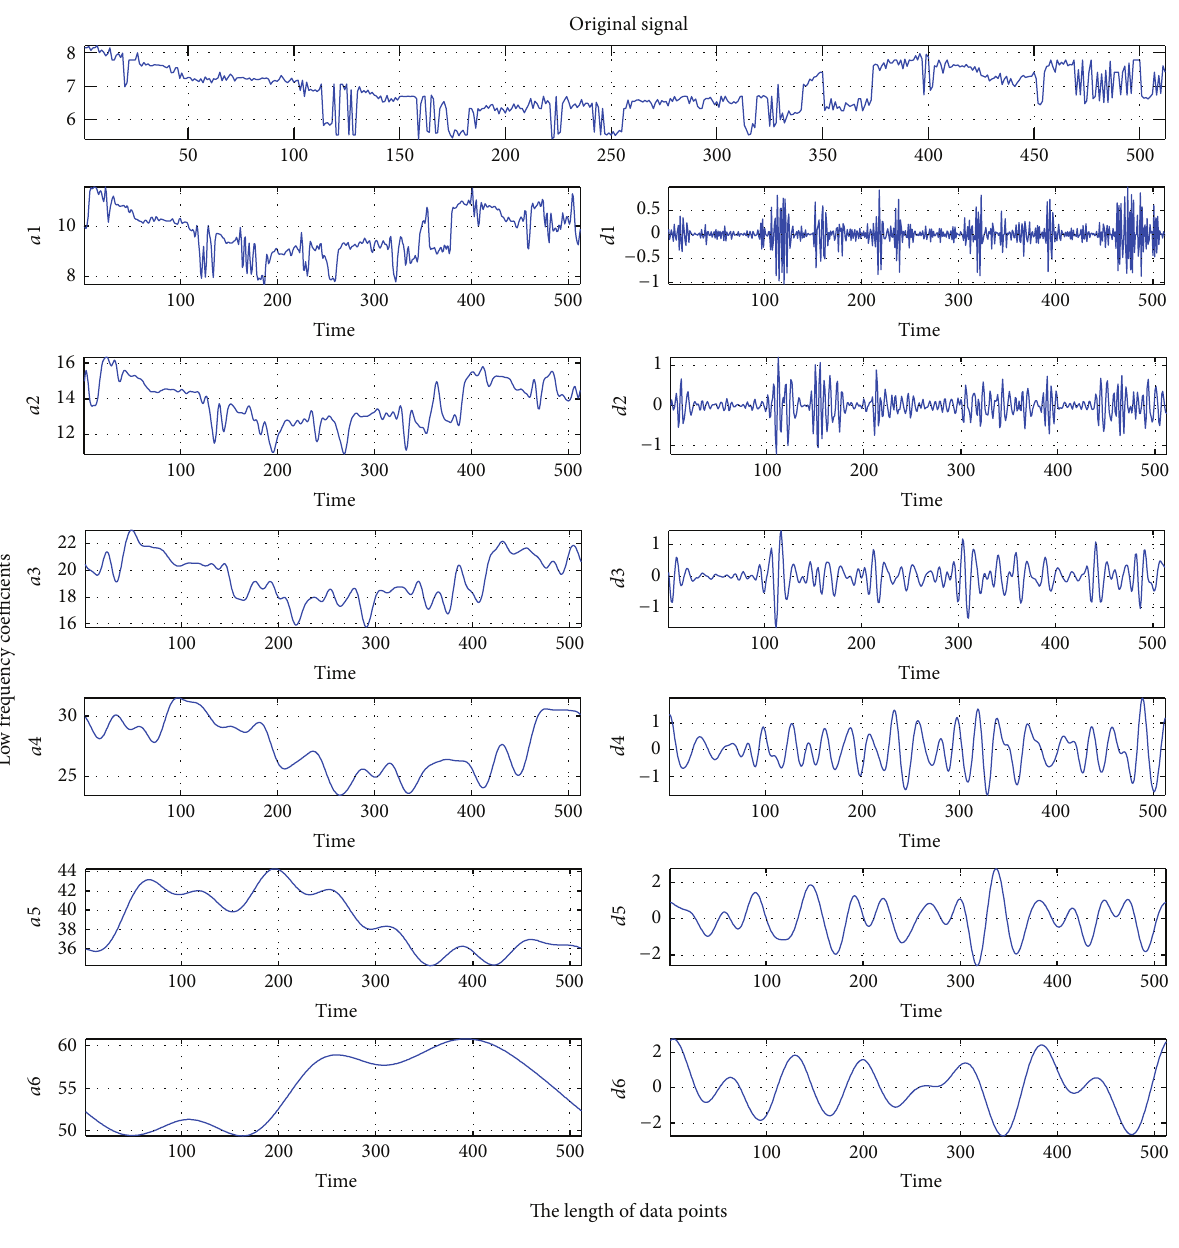
Figure 8: Original signal and six-layer wavelet decomposition of middle profile with